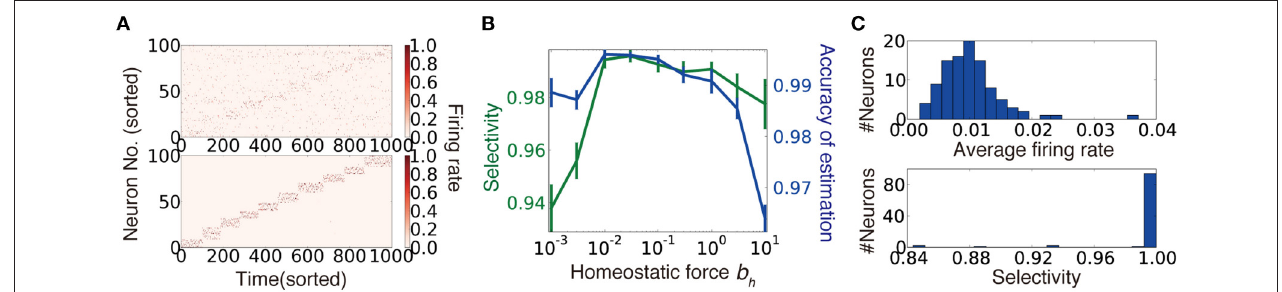
FIGURE 4 | Synaptic weight learning on random connection structures. (A) An example of output neuron activity before (top) and after (bottom) synaptic weight learning calculated at connectivity ρ 0.4. A diagonal line faintly observed in the upper panel reflects bias due to finite size effect (see Section Accuracy of = Estimation for details) (B) Selectivity of output neurons and accuracy of estimation at various strengths of homeostatic plasticity at ρ t t t r Y , i / Y , i for i ∈ (cid:127) µ . (C) Histogram of average firing rates of output neurons (top), and selectivity of each neuron calculated for the simulation depicted in (A) . s t µ r = P P